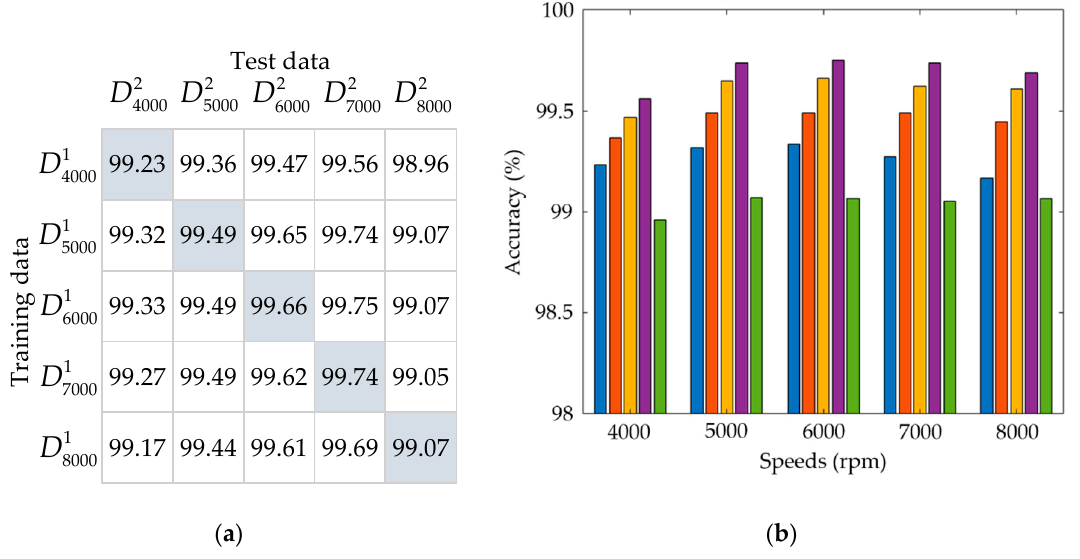
Figure 17. The percentage VA of the 25-order model: ( a ) The matrix chart; ( b ) The bar chart, wherein each group of bars corresponds to a row of the matrix chart.